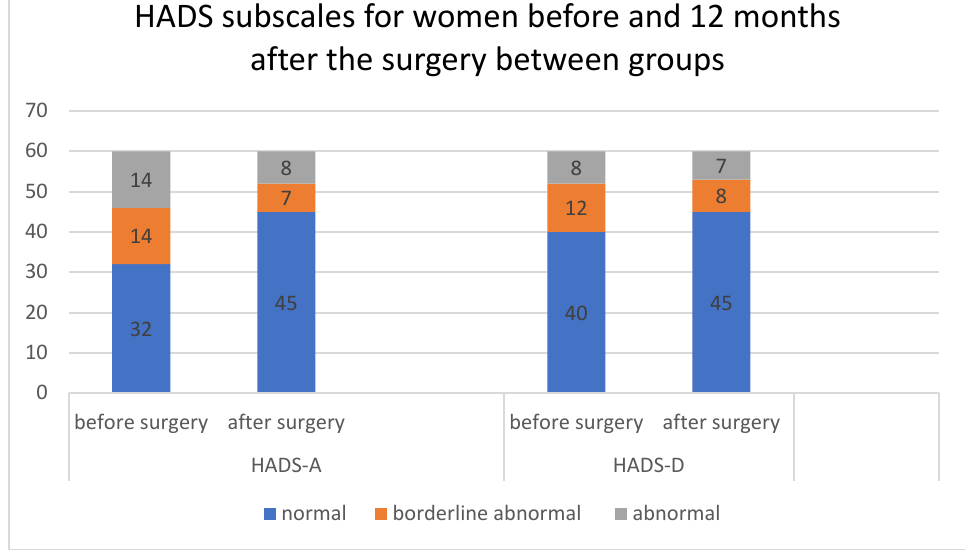
Figure 2. HADS subscales for women before and 12 months after the surgery between groups. Number of individuals in HADS-A and HADS-D (A — anxiety and D — depression, Hospital Anxiety and Depression Scale) before and 12 months after surgery.